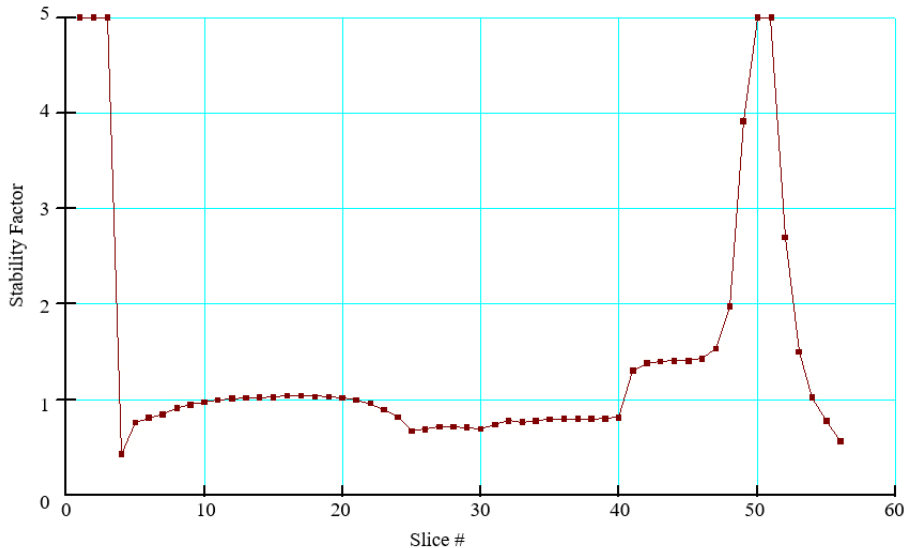
Figure 14. Local stability coefficient of landslide.